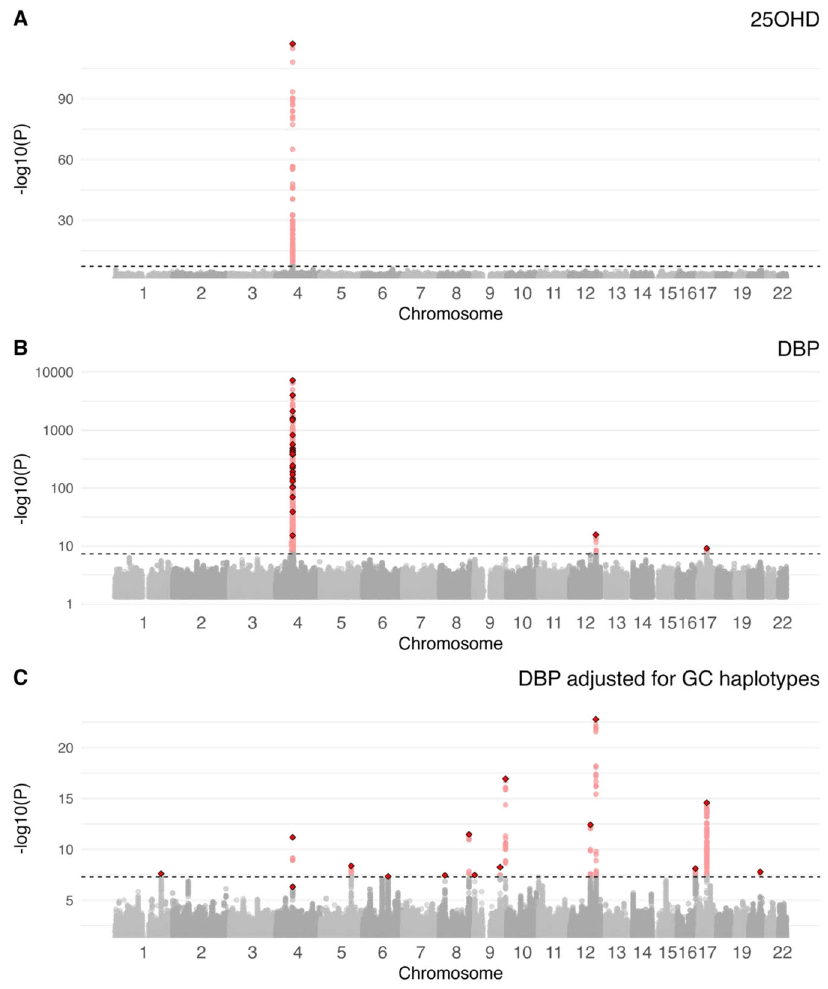
Fig. 4 | Manhattan plots for 25-hydroxyvitamin D (25OHD), vitamin D binding protein (DBP),and DBP adjusted for GChaplotypes in the iPSYCH case-cohort study. Panel A showstheManhattanplotfor25OHD,withoneprominentpeakover